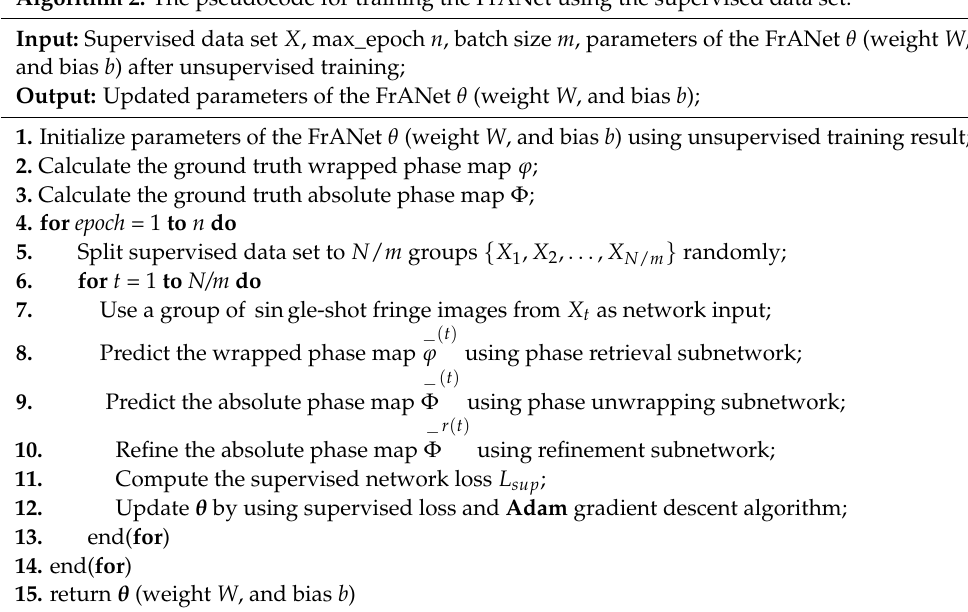
Algorithm 2. The pseudocode for training the FrANet using the supervised data set.